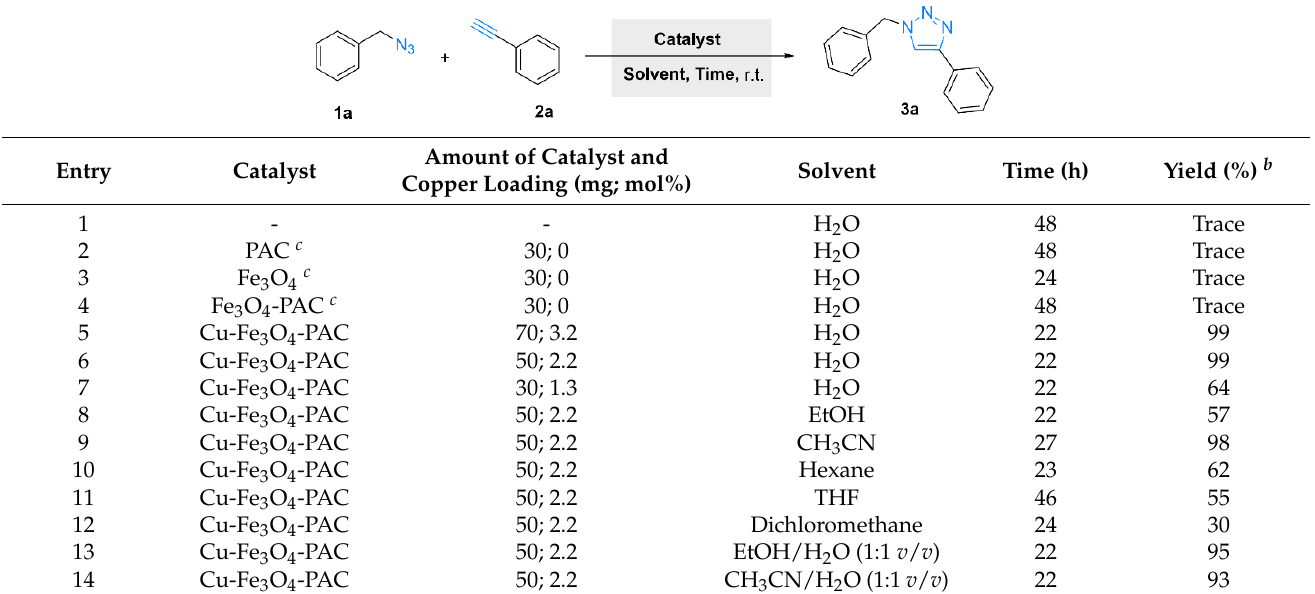
Table 2. Optimization studies a .